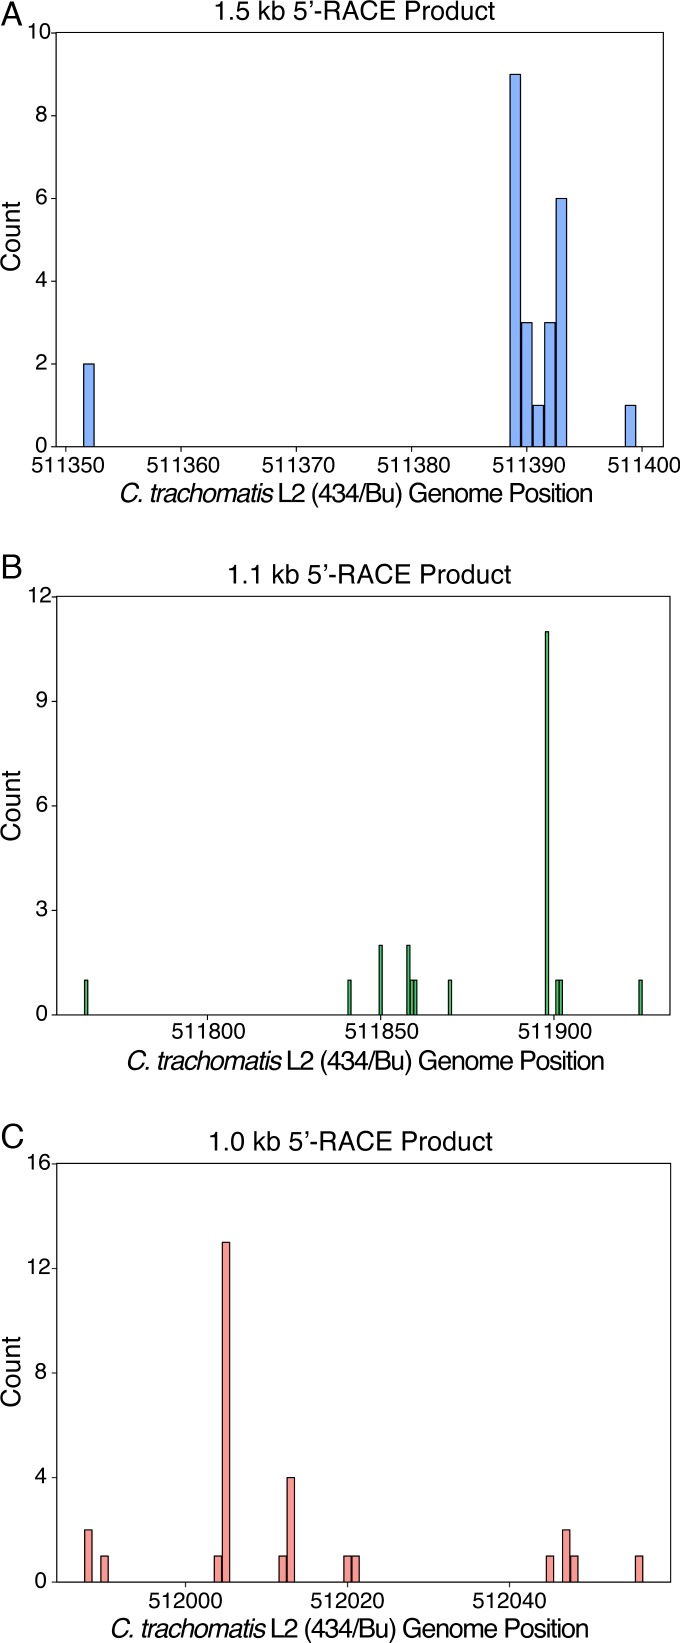
Mapping of 5’-RACE products at the individual nucleotide level.(A) Mapping of the 1.5 kb 5’-RACE product. (B) Mapping of the 1.1 kb 5’-RACE product. (C) Mapping of the 1.0 kb 5’-RACE product.